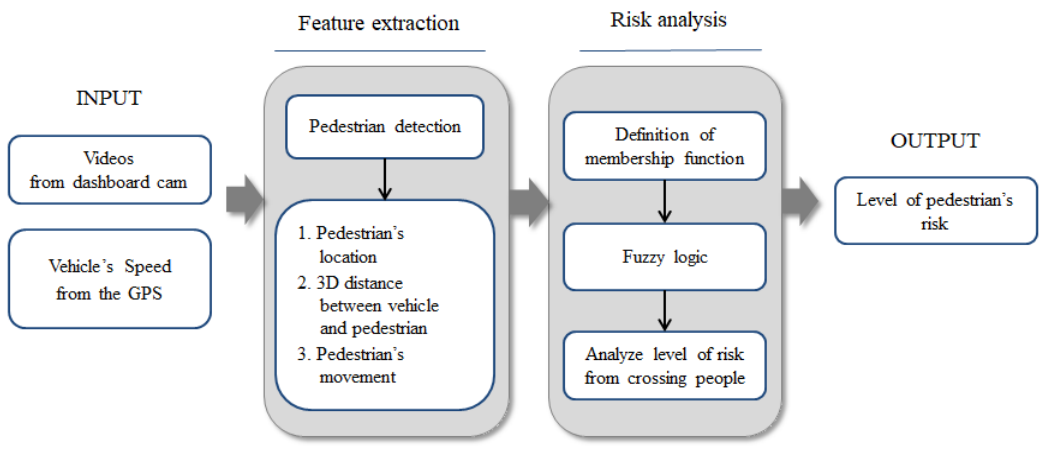
Figure 1. Overview of the proposed system: The system has two main modules, a feature extraction module and a risk analysis module. These take videos from a car dash camera and vehicle speed information from an external GPS module, and output the level of risk to pedestrians.